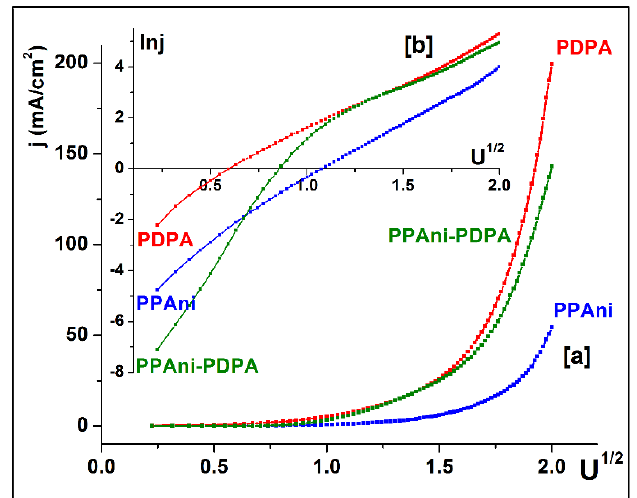
Figure 12. ( a ) Plots of j vs. U 1/2 and ( b ) identification of Schottky behavior for PPAni, PDPA, and PPAni-PDPA films.